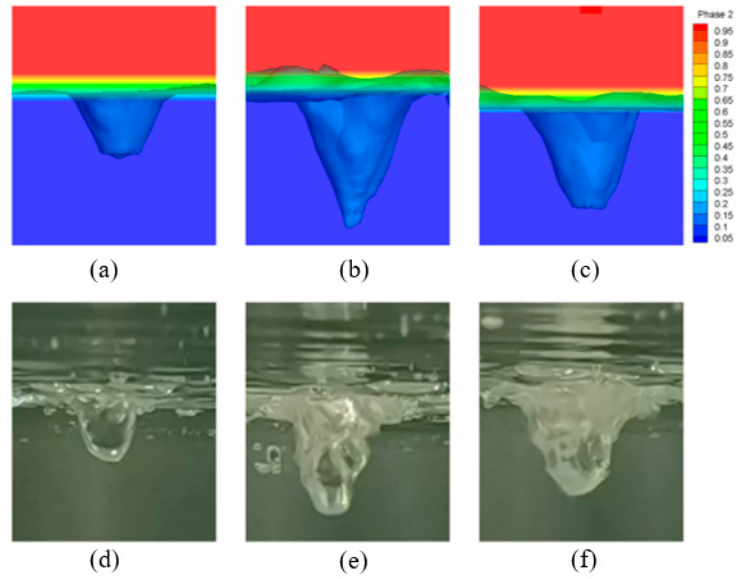
Figure 5. Comparison of cavity shape in the simulation ( a – c ) and experiment ( d – f ).